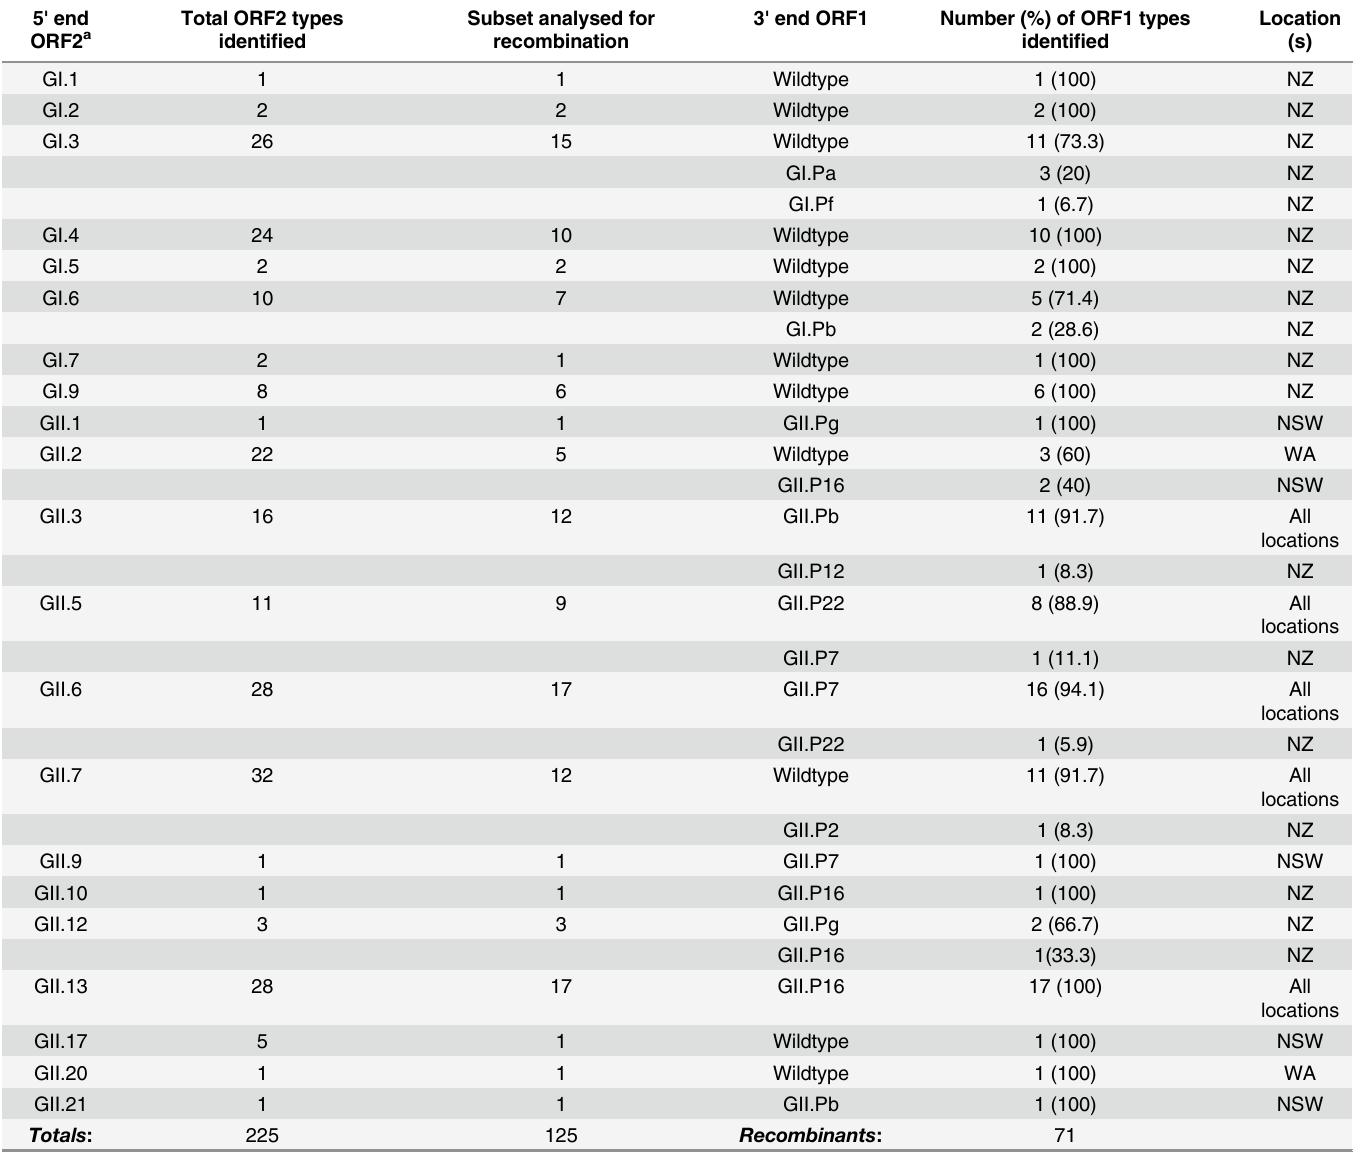
Table 3. NoV wildtypes (non-GII.4) and intergenotypic recombinants identified in this study. 5' end ORF2